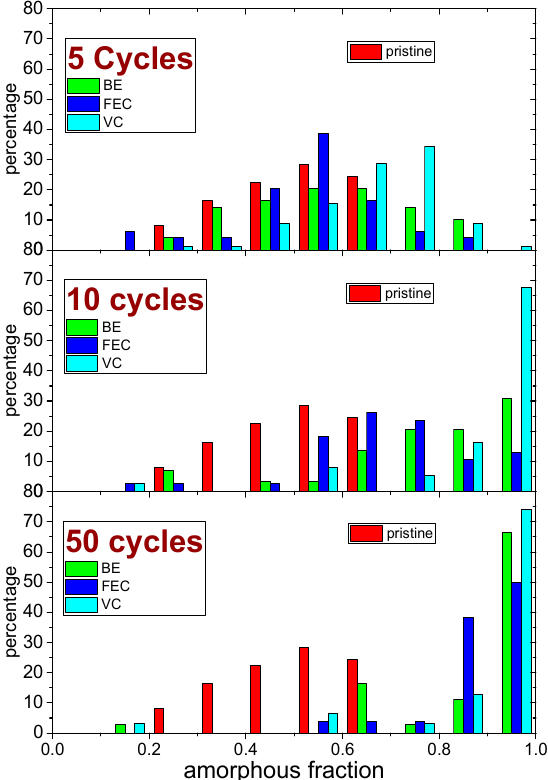
Figure 6. Comparison of the distribution of amorphous fraction (in steps of 0.1) of the Si NW samples, before (pristine) and after 5, 10 and 50 lithiation–de-lithiation cycles in the three different electrolytes (BE, FEC and VC).